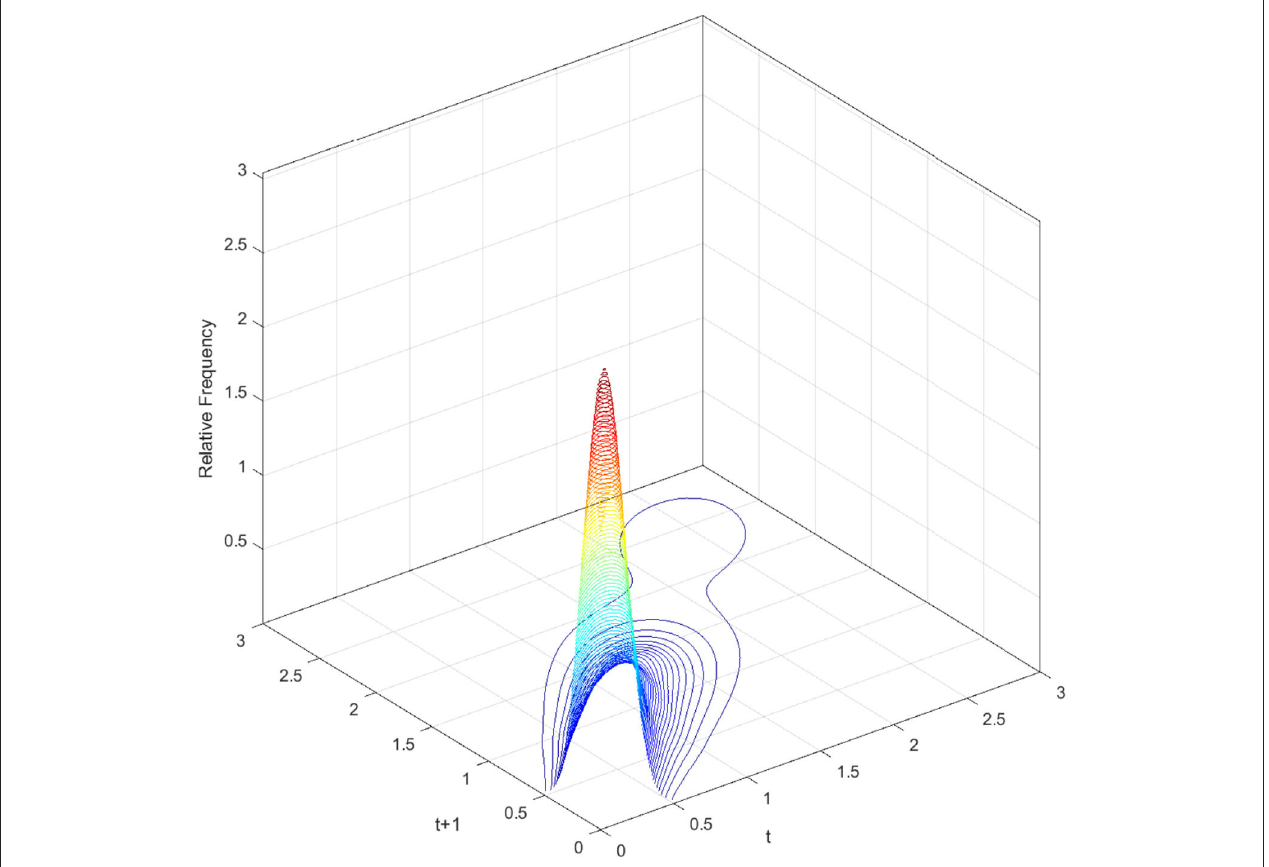
FIGURE 1 | Three-dimensional plot of transition probability kernel for the relative RIVAPC of all countries with annual transitions. Source: authors’ calculation. N.B. The vertical axis indicates the probability of transition at the country level from one particular RIVAPC value in year t to another RIVAPC value in year t +